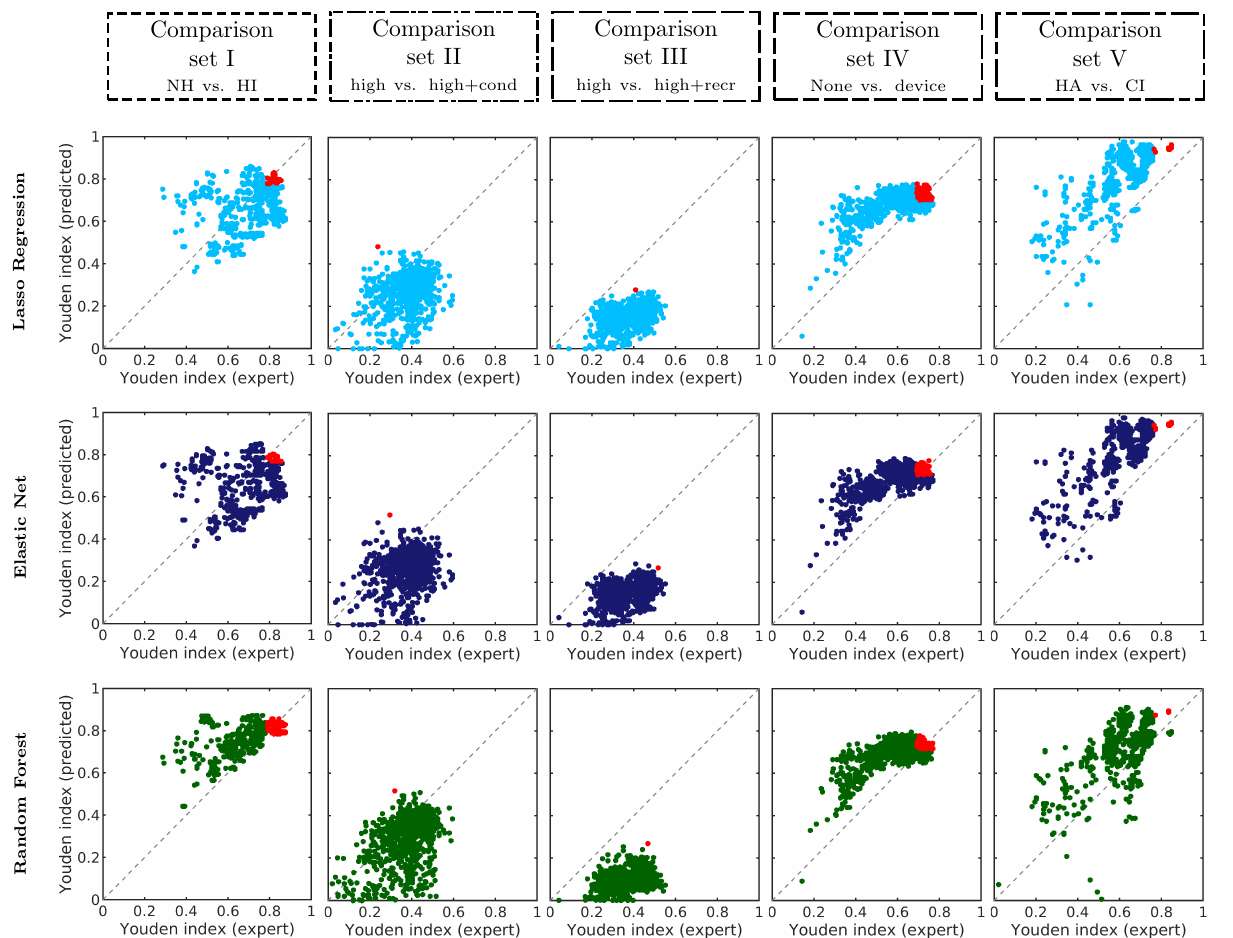
Figure 4. Youden index scatter plots for all 1023 binary combinations of CAFPAs. Rows and colors depict results for different CAFPA prediction models, while columns depict comparison sets. In each panel, the Youden index Y for predicted CAFPAs is plotted against the Youden index Y for expert-estimated CAFPAs. Red data points represent Y90